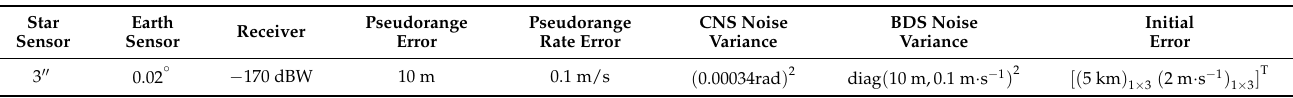
Table 5. Sensors and filter parameter settings.